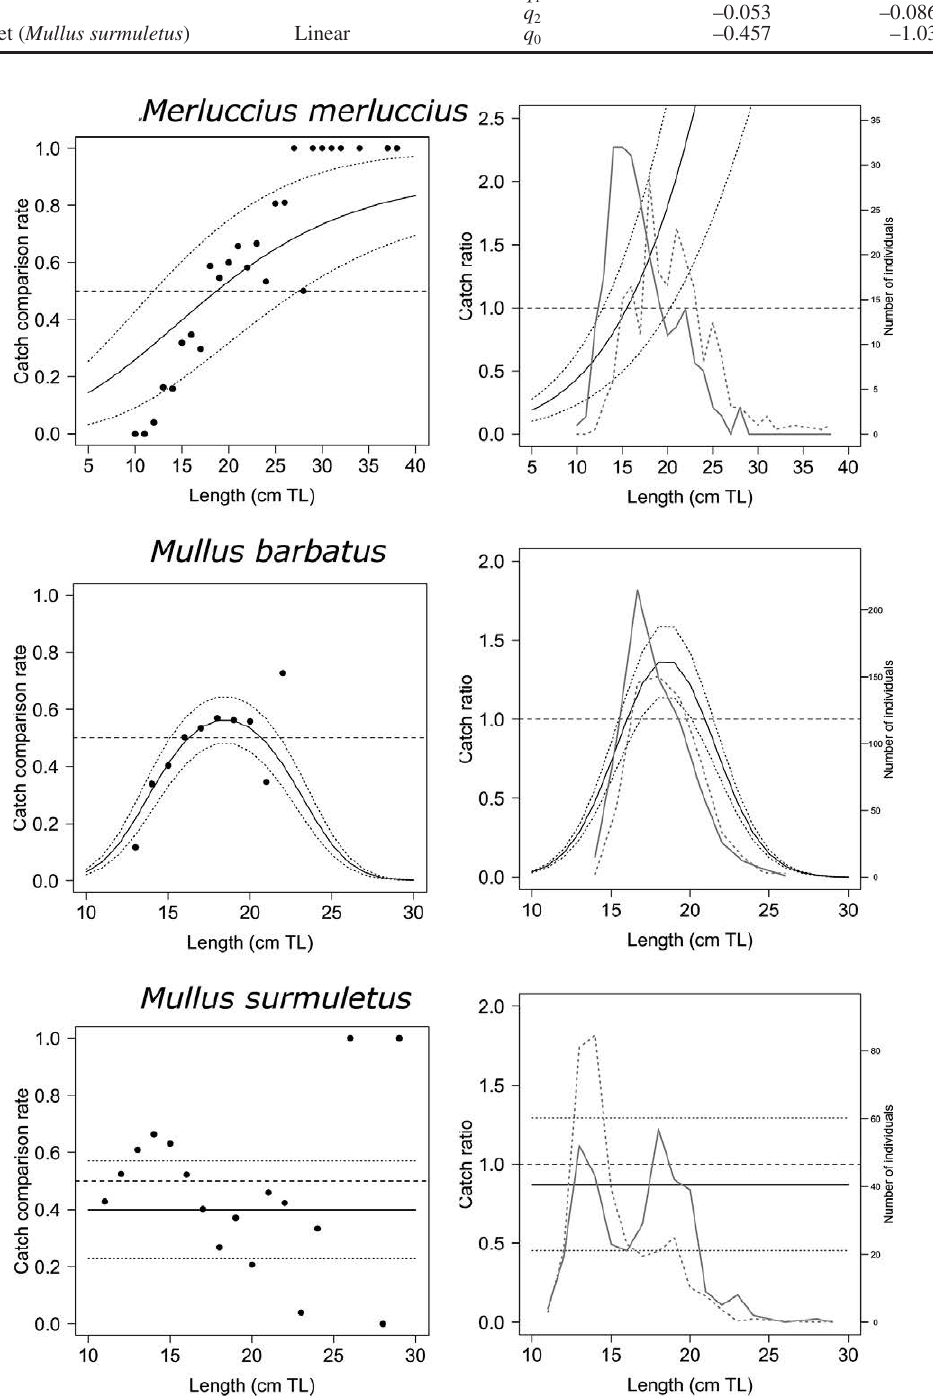
Fig. 4. – (left) Catch comparison curves for the models selected: filled circles are observed proportions, pooling all trawl hauls. Solid lines represent the mean, dotted lines 95% confidence intervals. The level of no effect ( CC ( l, v )=0.5) is shown by the horizontal dotted line. (right) Catch ratio curves (solid black lines, mean; dotted black lines, 95% confidence intervals) and observed catch frequency (grey lines, continuous control trawl; dotted lines, experimental trawl). The level of no effect ( CR ( l, v )=1.0) is show by the horizontal dotted line. Model parameters are shown in Table